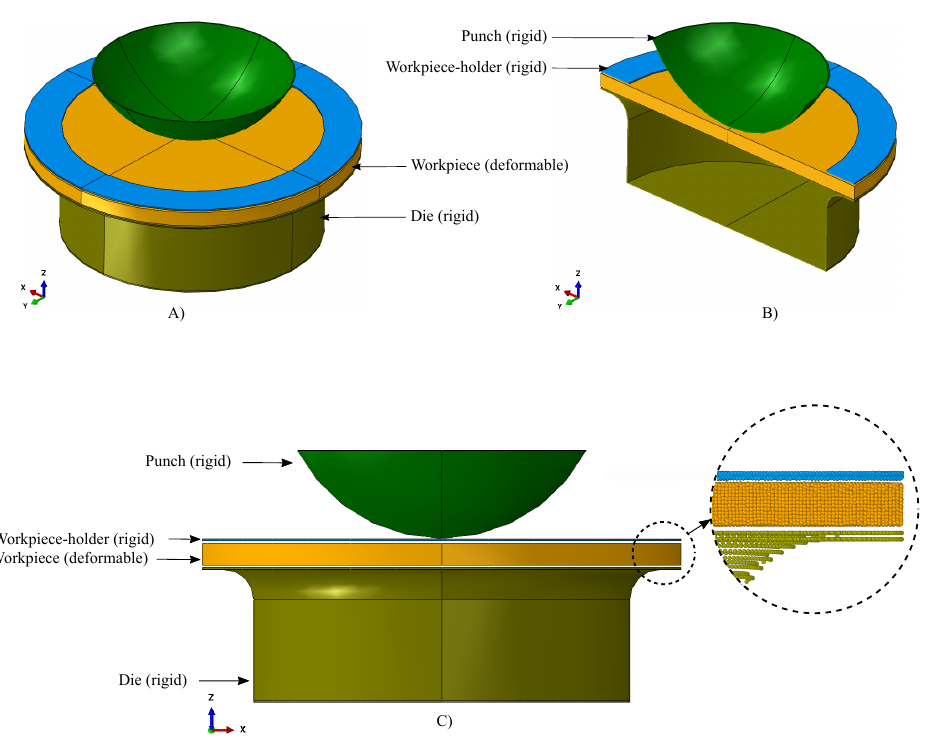
Figure 1. Schematic setup of the all-atom gas detonation forming model. ( A ) A isometric view, ( B ) a half sectional isometric view, and ( C ) 2D front view of the all-atom model. The enlarged view shows gaps between die, workpiece, and